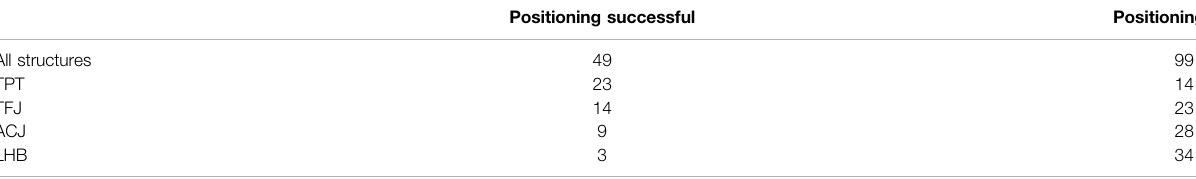
Positioning successful